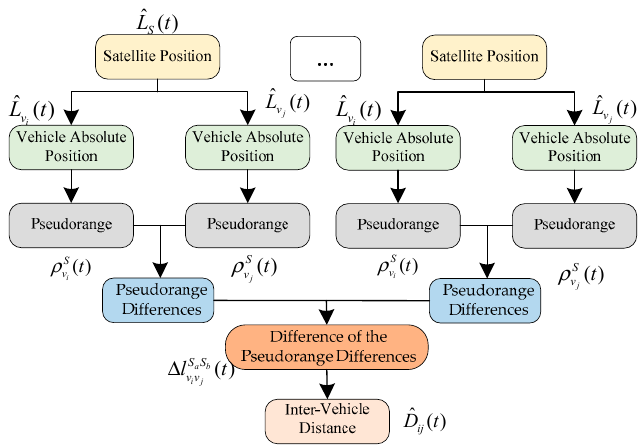
Figure 8. Flowchart of double difference (DD)-based IVD estimation method.